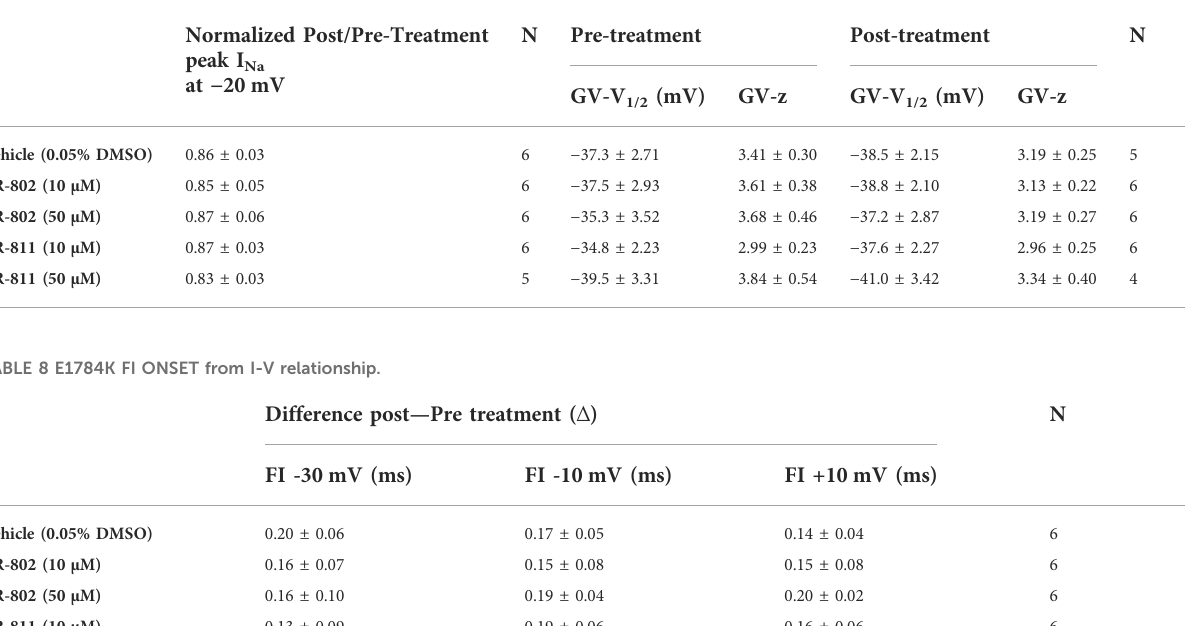
TABLE 7 E1784K peak I NA and conductance.